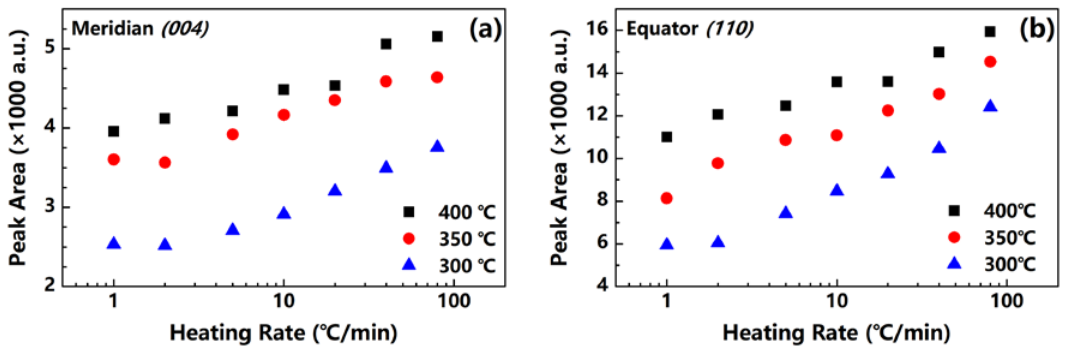
Figure 7. Areas of ( a ) (004) and ( b ) (110) diffraction peaks of PI fibers obtained under different heating rates.